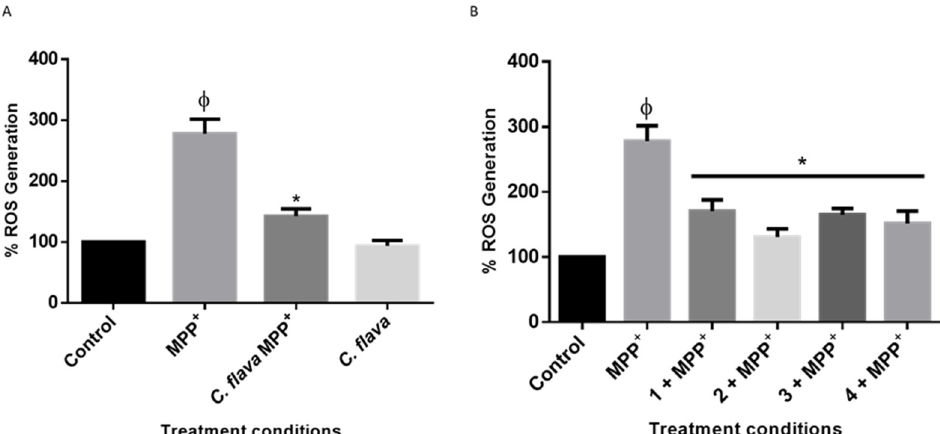
Figure 5. Crossyne flava and compounds mitigated ROS production induced by MPP + . SH-SY5Y cells were pre-treated with 2.5 µ g/mL of C. flava ( A ) and 2.5 µ g/mL of compounds ( B ) before exposure to MPP + for 24 h, and ROS production was measured using DCFDA fluorescent dye. Each bar represents the mean fluorescent intensity expressed as a percentage of the control. The significance of the difference is indicated by * p < 0.05 when extract/compounds are compared to MPP + -treated cells. φ Represents MPP + vs. the control.